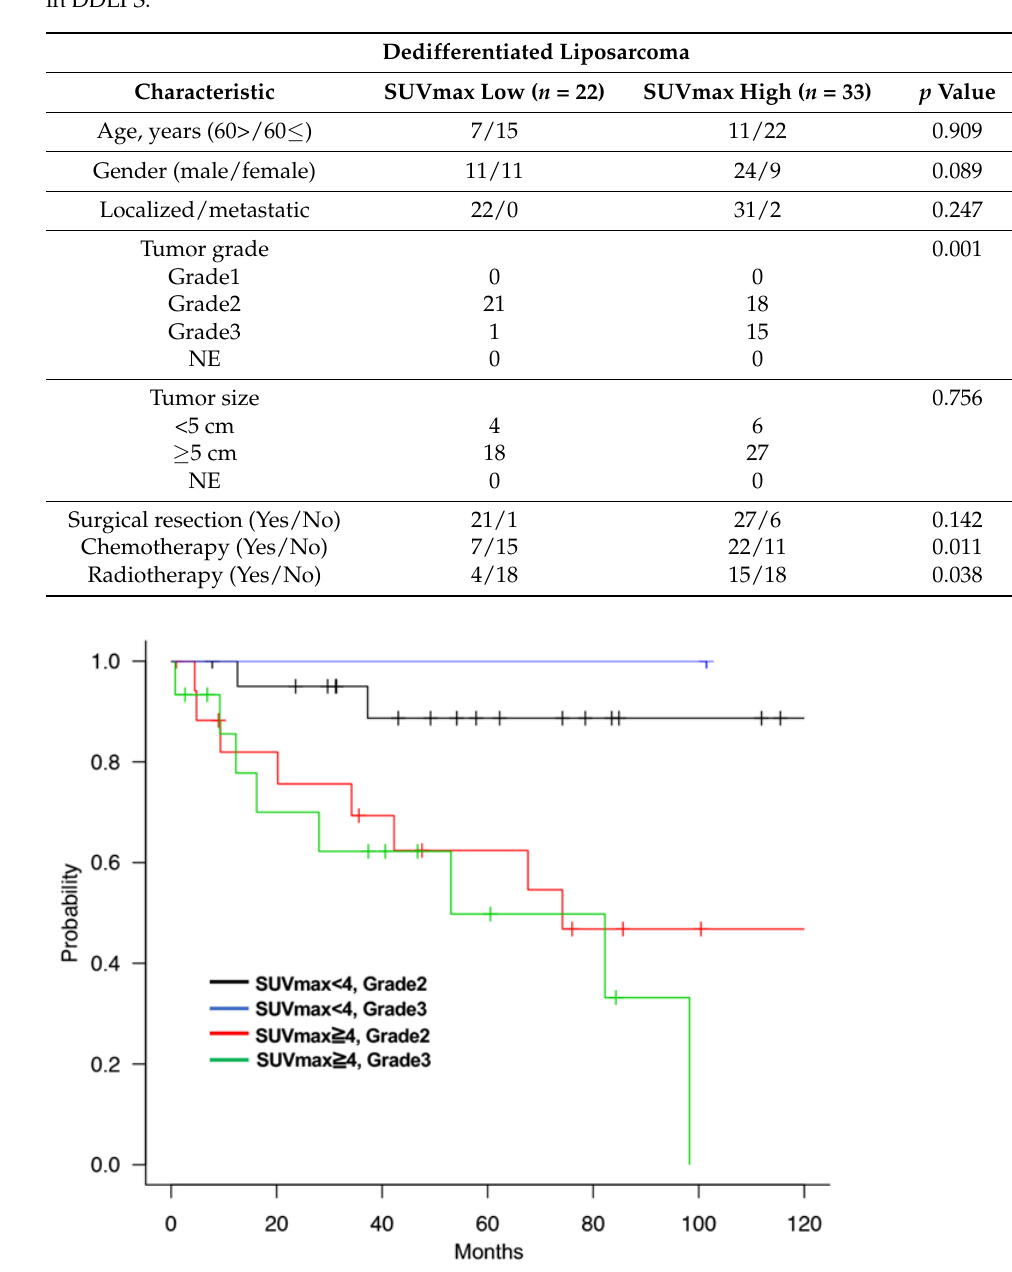
Figure 5. OS of DDLPS patients with SUVmax low and Grade2, SUVmax high and Grade2 and SUVmax and Grade3.